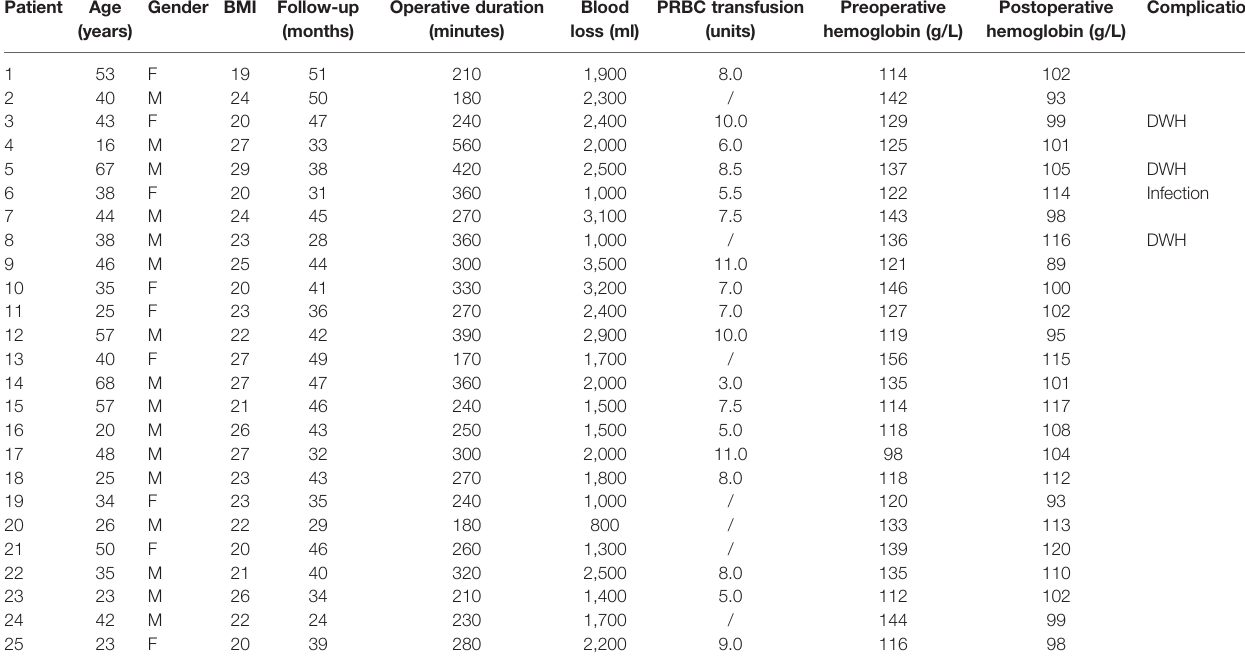
TABLE 1 | Demographics of the 25 patients treated with 3D-printed custom-made integrative hemipelvic endoprostheses via two approaches. Patient Age Gender BMI Follow-up (years)